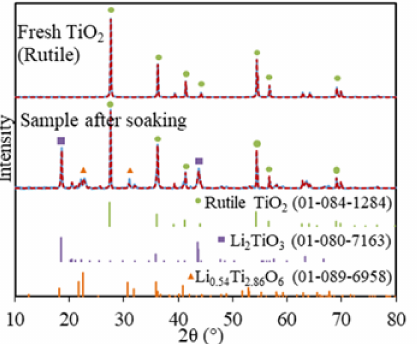
Figure 1. XRD for fresh TiO 2 (rutile) and soaked TiO 2 in molten LiCl–Li 2 O (1 wt.%) for 5 h at 650 ◦ C (blue solid lines) and Rietveld refinement fittings (red dash lines, with rutile TiO 2 , Li 2 TiO 3 , and Li 0.54 Ti 2.86 O 6